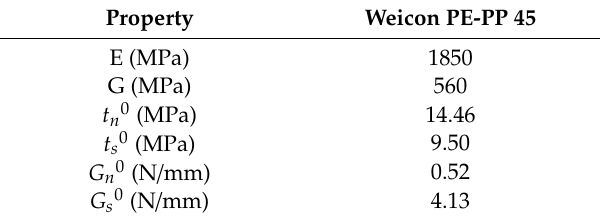
Table 3. Properties of the Weicon PE–PP 45 adhesive used for CZM modelling. Property